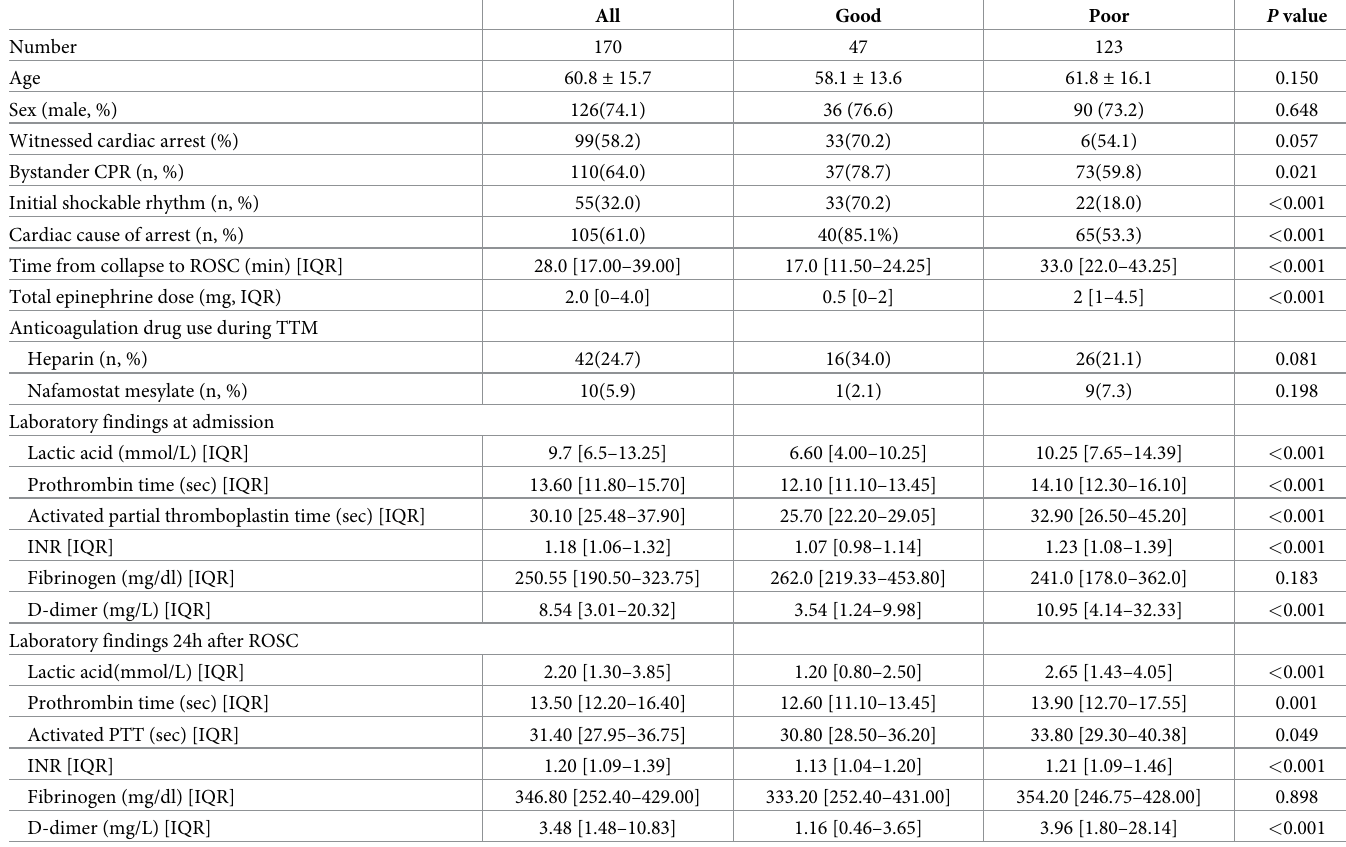
Table 1. Demographic findings according to neurological